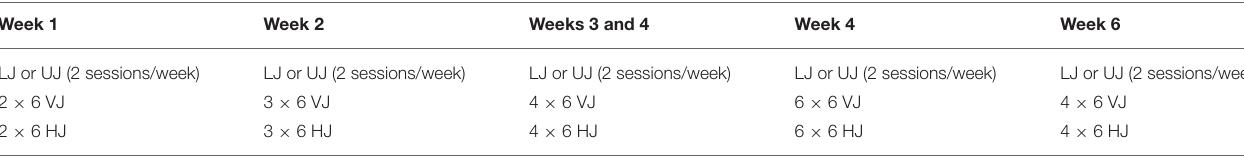
TABLE 2 | Training protocols for both groups over the 6-week training period.